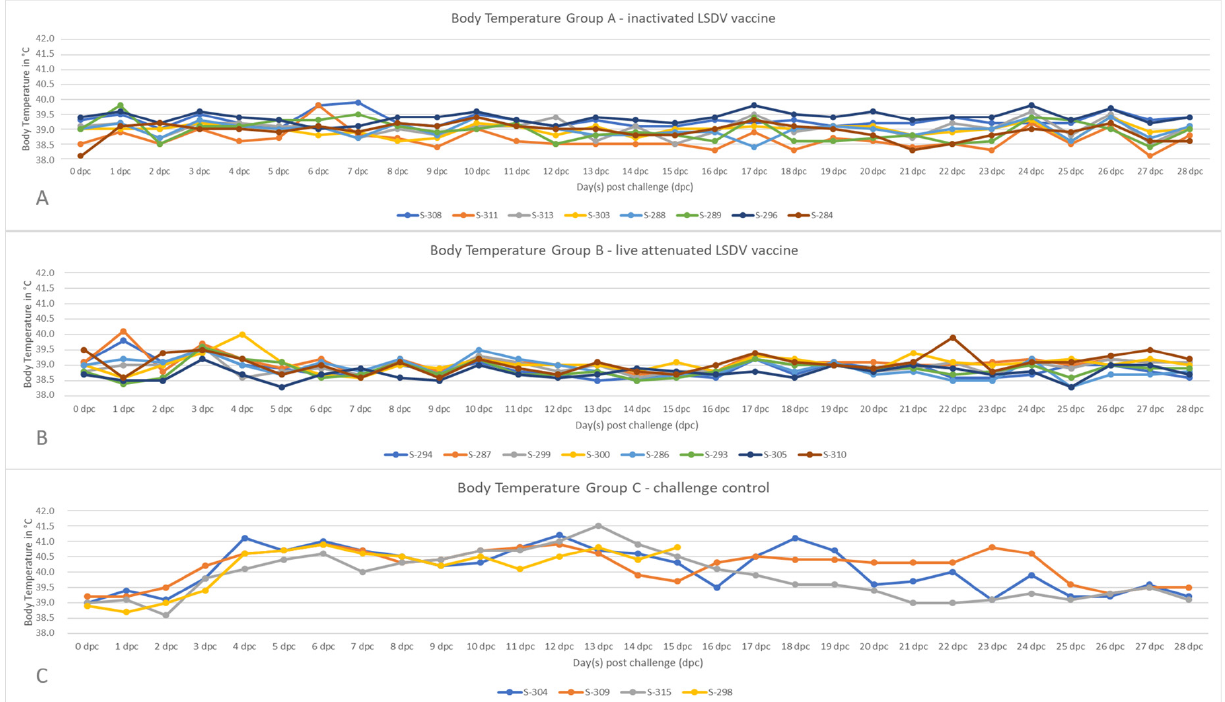
Figure 1. Body temperature after challenge infection. The body temperature of all animals was measured daily from 0 dpc to 28 dpc. Increased body temperature was defined ≥ 40.0 ◦ C. ( A ) The animals of group A were vaccinated twice with an inactivated LSDV vaccine candidate. ( B ) The sheep of group B were vaccinated once with the live-attenuated LSDV vaccine strain. ( C ) The animals of group C served as the unvaccinated challenge control